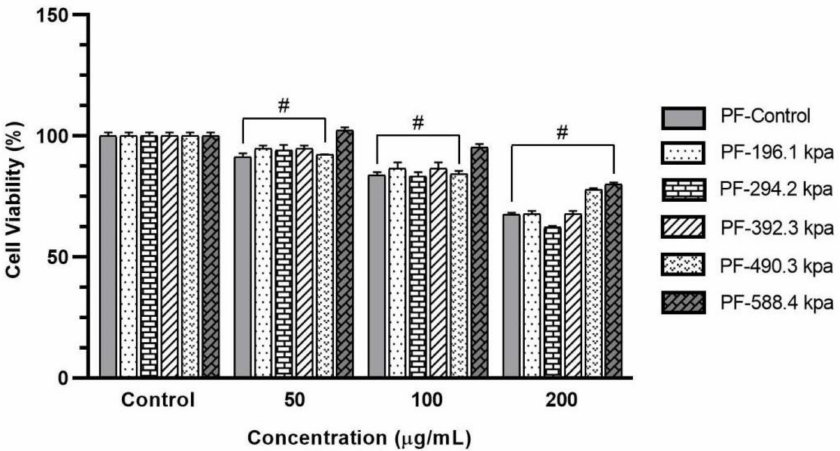
Figure 6. Effect of puffed CRMG on cell viability of HaCaT cells. The graph showed mean ± SD values of four replications. # p < 0.05 indicates significant differences from control